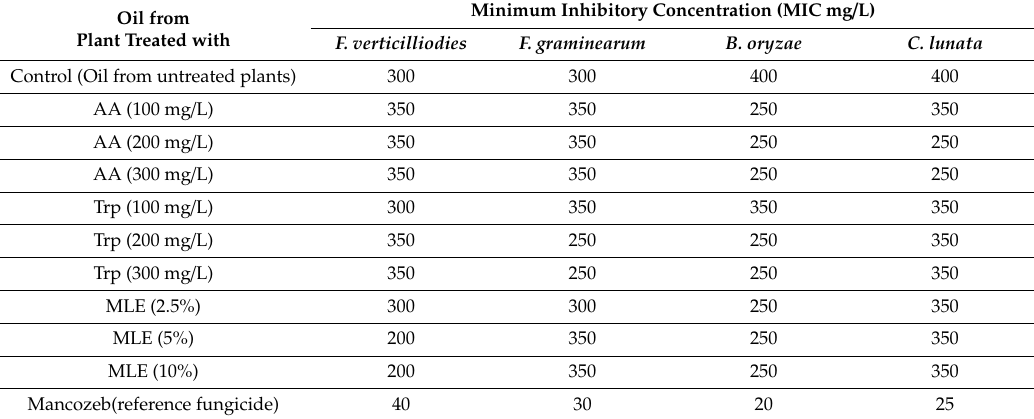
Table 7. Minimum inhibitory concentrations (MICs) of the essential oil treatments and reference fungicide.